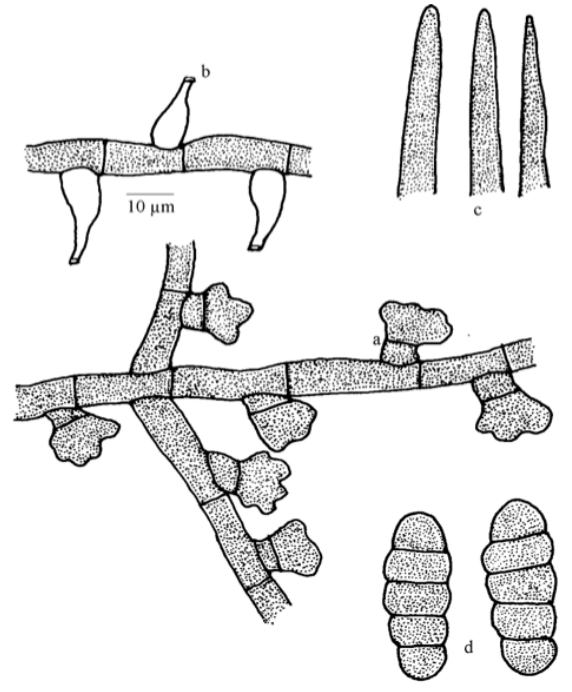
Figure 114. Meliola stenospora a - Appressorium; b - Phialide; c - Apical portion of mycelial setae; d - Ascospores